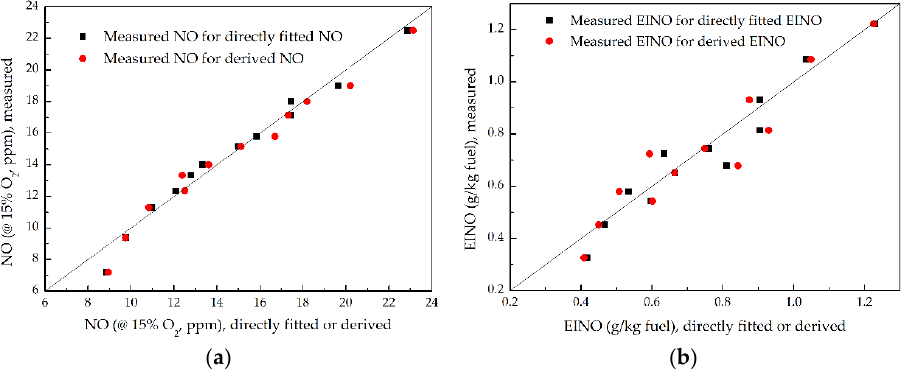
Figure 14. Predictions of NO and EINO from their directly fitted correlation and derived correlation: ( a ) NO; ( b ) EINO.